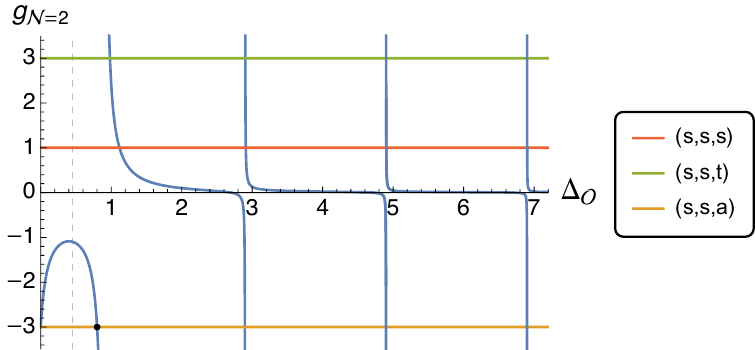
Figure 9 . Solutions of eigenvalue problem for scalar bilinears in various representations in d = 2 . 8 dimensions. The black dots corresponds the global symmetry current multiplet. The vertical dashed line corresponds to the unitarity